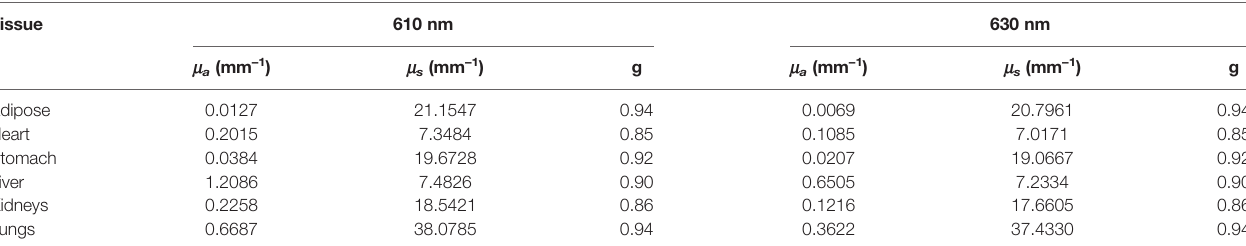
TABLE 1 | Optical parameters of the mouse tissues for 610 and 630 nm. Tissue